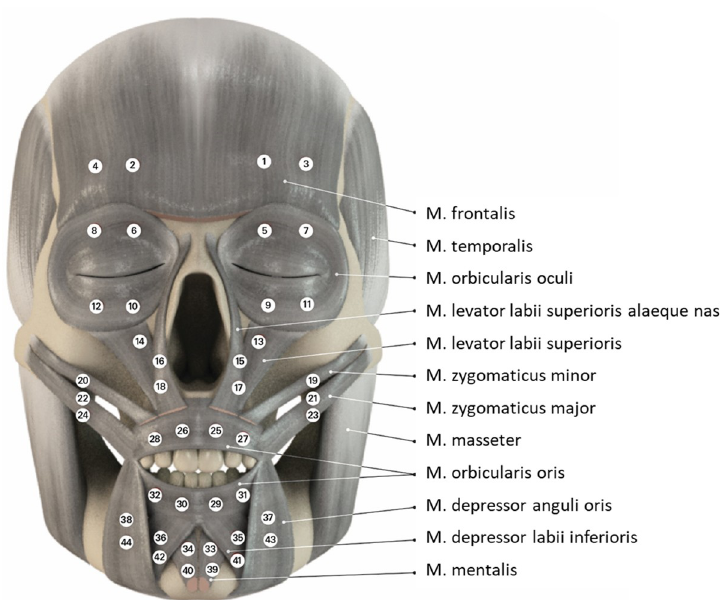
Fig 1. sEMG electrode arrangement. 44 electrodes were placed symmetrically on 10 mimic muscles on both sided of the face,